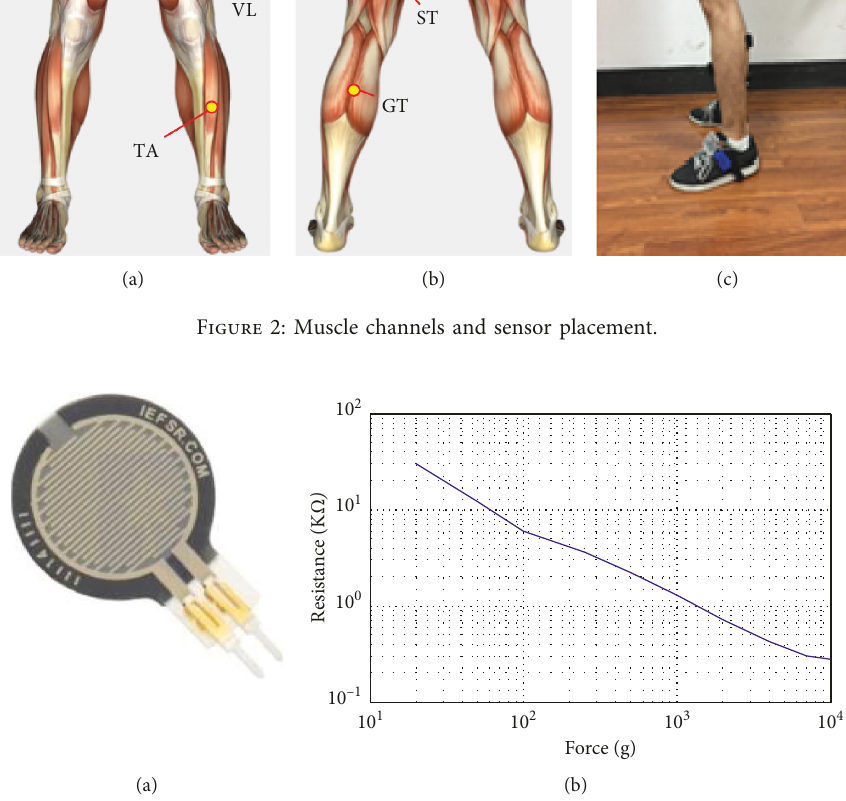
Figure 3: FSR402 pressure sensor and transfer characteristic curve.